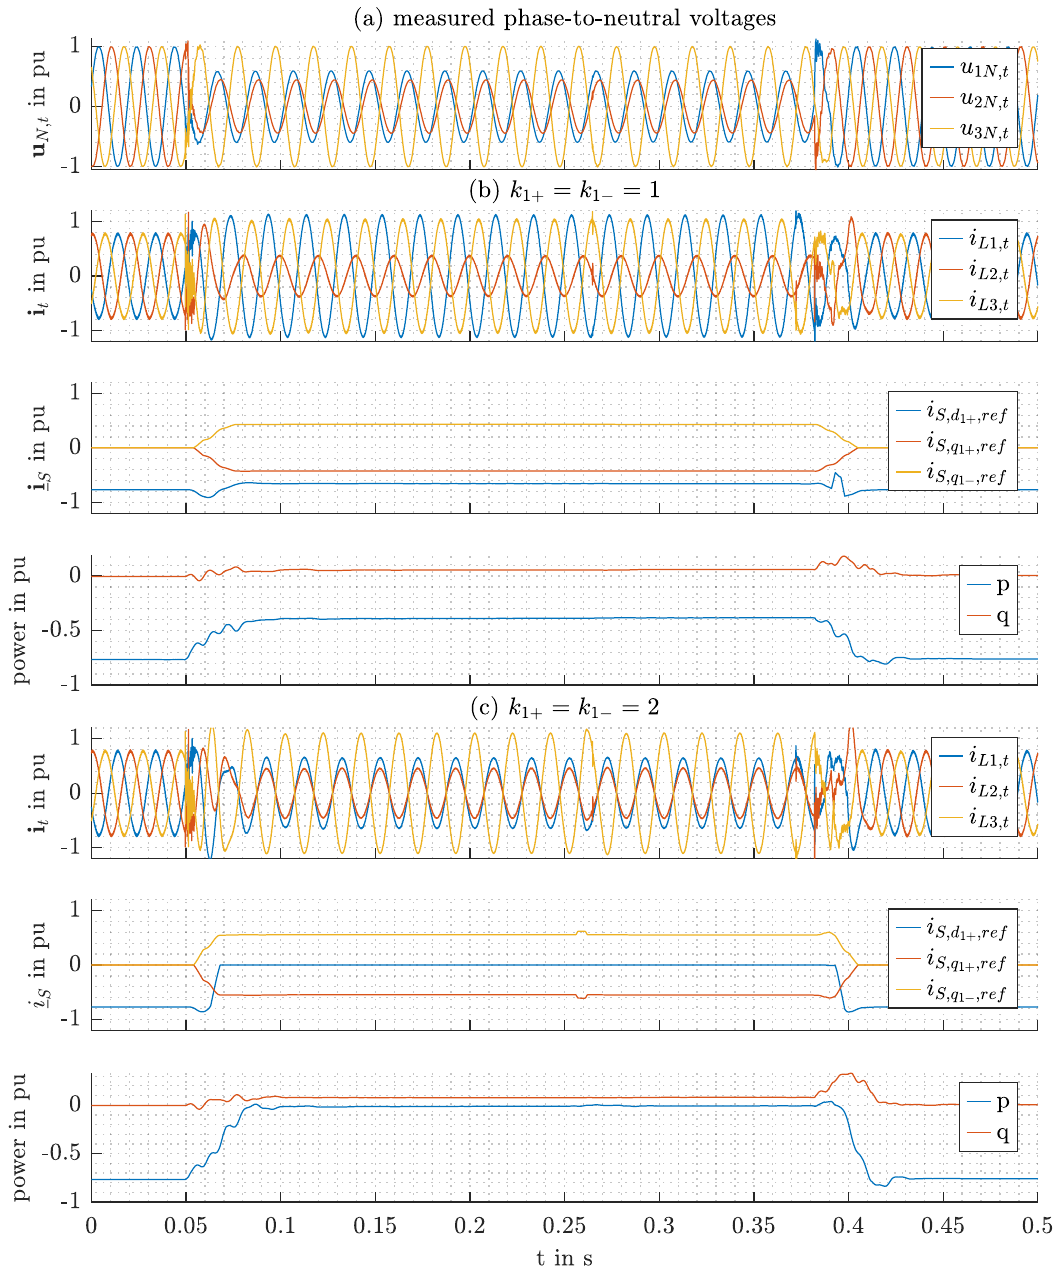
Figure 6. Simulation results of a two-phase short-circuit (the load reference system is